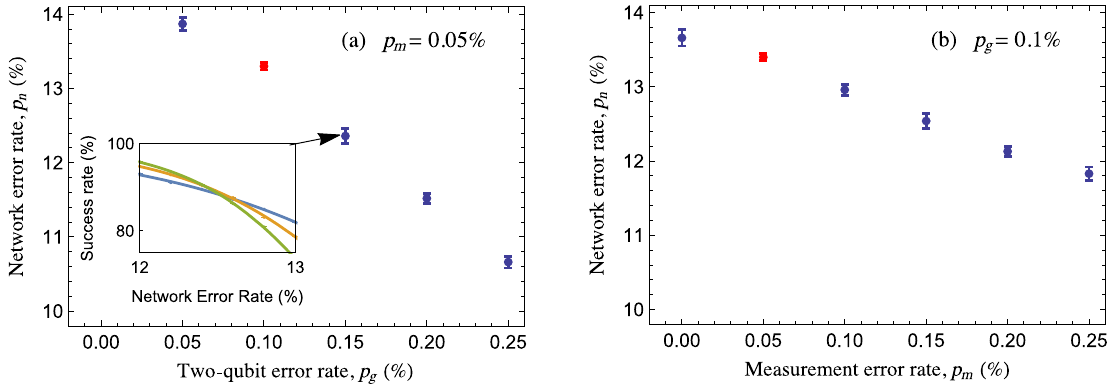
FIG. 12. Threshold dependence on local error rates for the medium protocol. The threshold for fault tolerance is dependent on all the physical error rates in the system. In Fig. 4, we show the threshold in the network error rate p when the local measurement and gate n error rates p and p are fixed to 0.05% and 0.1%, respectively. Here, we demonstrate the robustness of the protocol to changes in these m g intracell error rates. In (a), we show the threshold ’ s dependence on p , while (b) reveals the dependence on p . Each plotted point g m represents an entire threshold calculation as shown in the inset of (a). The red data points correspond to the values discussed in the main text. We stress that as the errors deviate further from this point, it is likely that our protocol becomes suboptimal; thus, the threshold line should be regarded as a lower bound on the possible